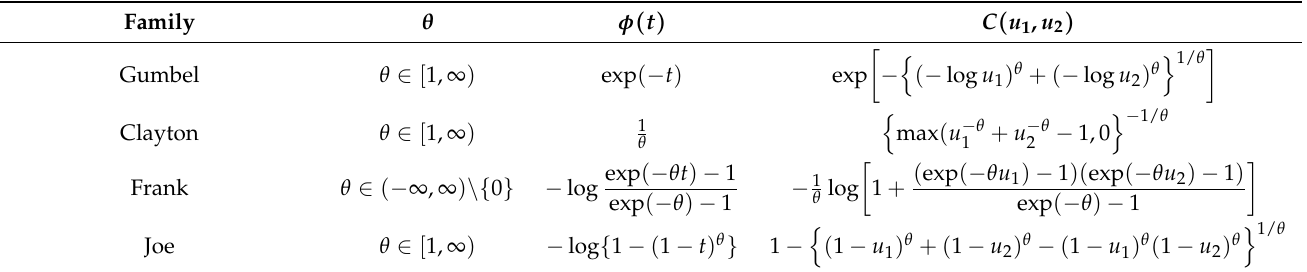
Table 5. Archimedean copula families with one-parameter generator functions φ used in this paper. Family θ φ ( t ) C ( u 1 , u 2 )